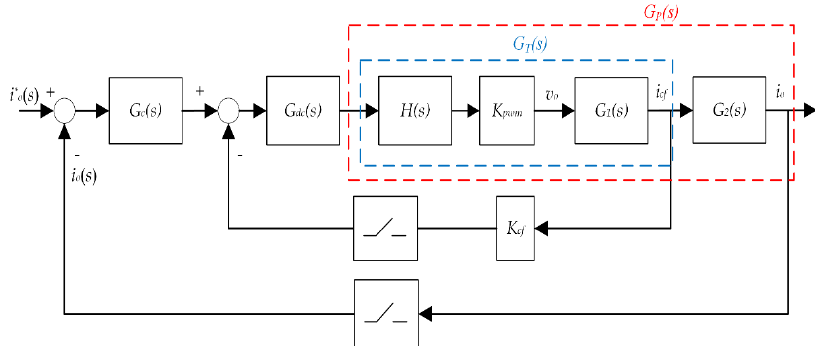
Figure 7. Output current controller model in the s ‐ domain.